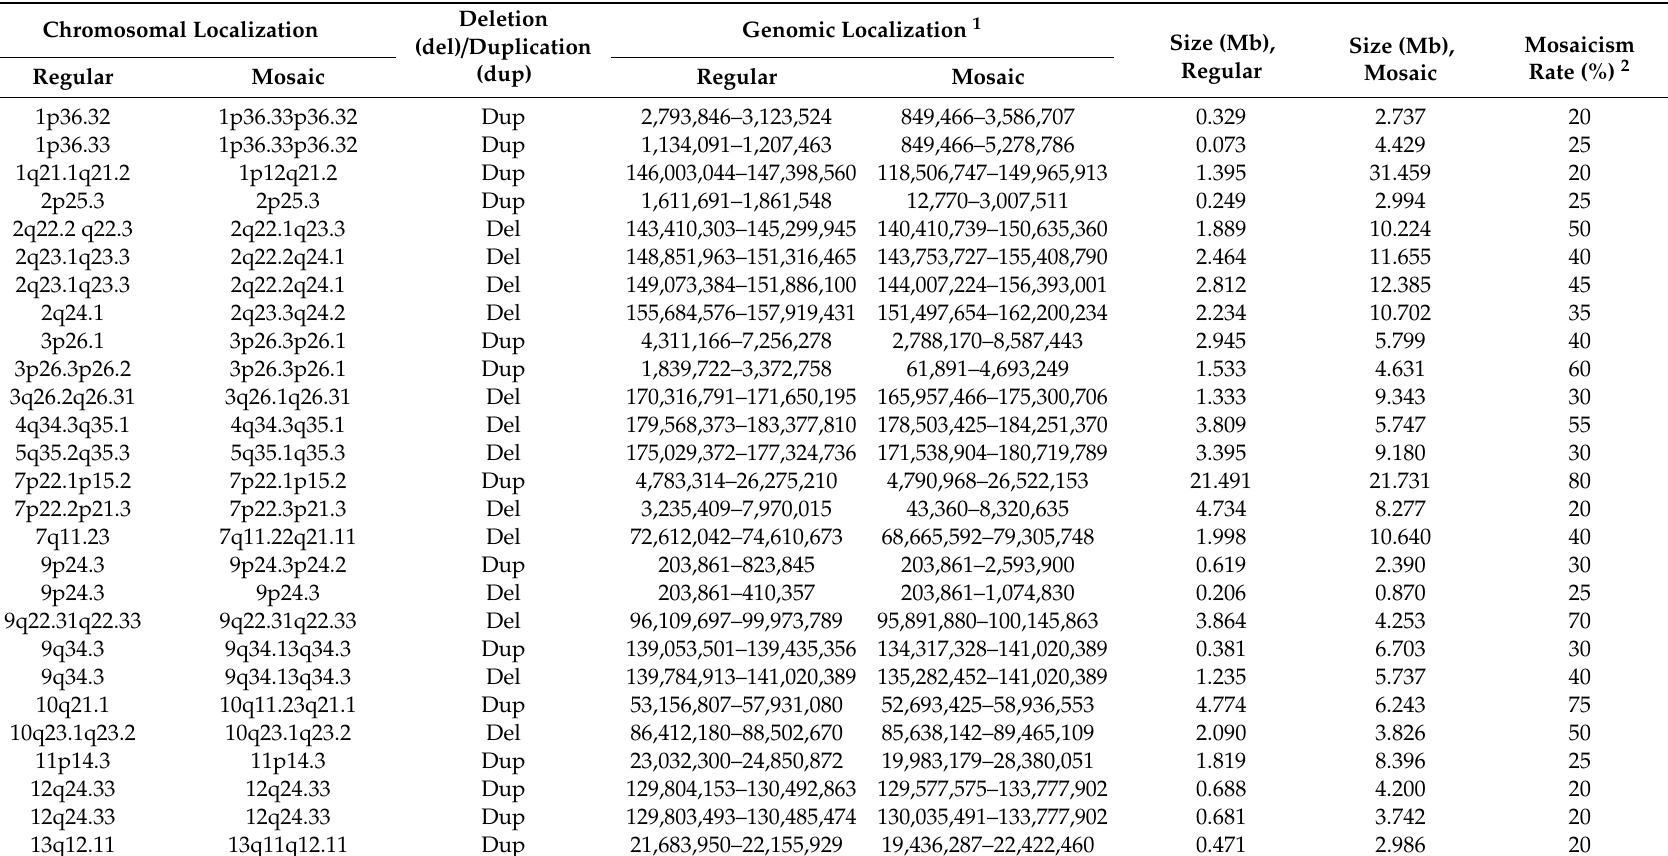
Table1. Colocalizedregular / mosaicchromosomeimbalancesandcopynumbervariations(CNV)markingchromosomallocia ff ectedbychromohelkosis(chromohelkosis